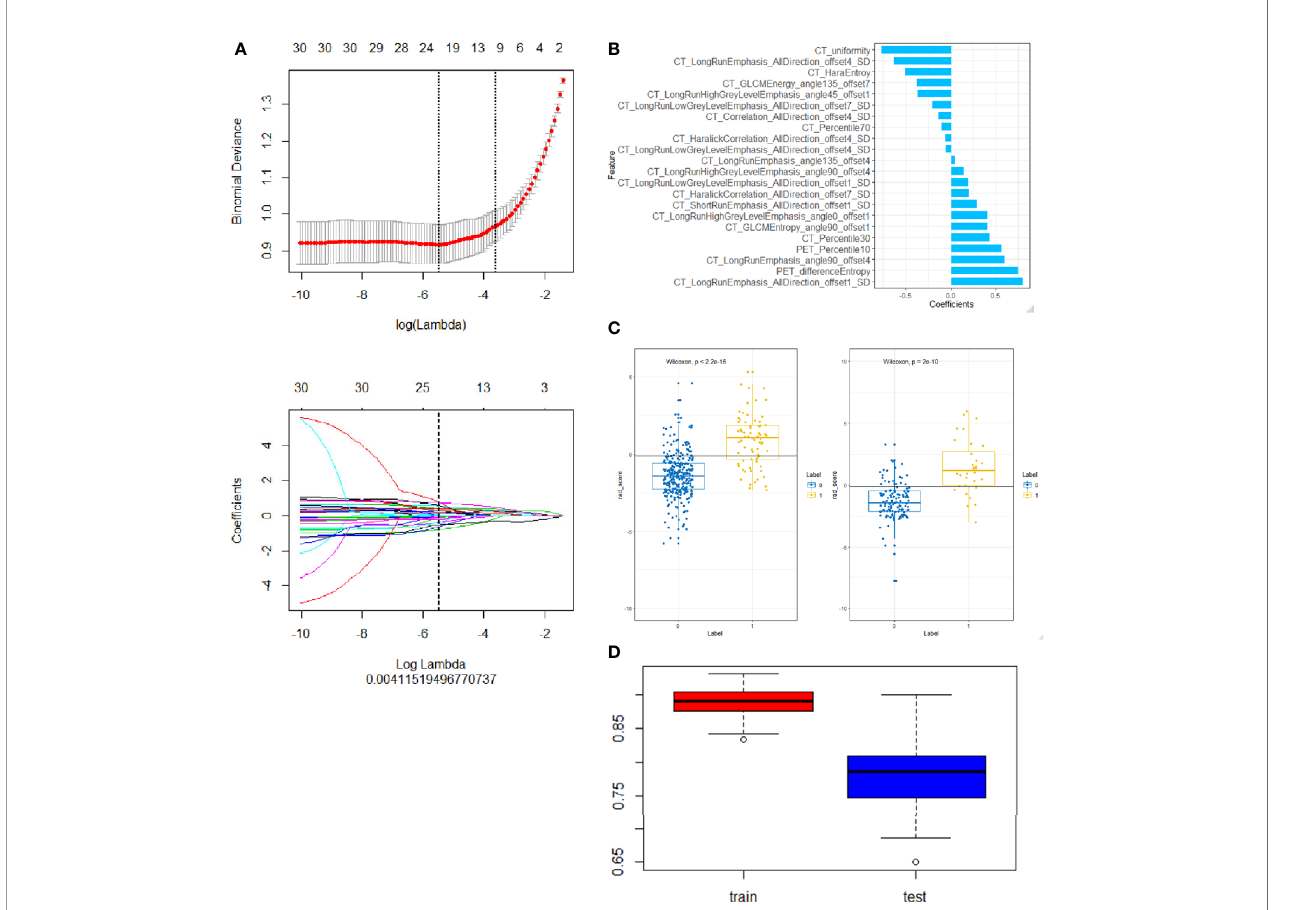
FIGURE 3 | Construction of a PET/CT radiomic model based on PET/CT images. (A) the Selection of the tuning parameter ( l ) in the LASSO model via 10-fold cross-validation based on minimum criteria. Binomial deviances of the LASSO regression cross-validation model are plotted as a function of ln ( l ). The y-axis shows binomial deviances and the lower x-axis the ln ( l ). Feature numbers along the upper x-axis indicate the number of features via the change of l . (B) The fi nal retained features selected by mRMR, y axis was the retained features and x axis shows the corresponding LASSO regression coef fi cients of them. The fi tted coef fi cients of the features plotted vs. ln ( l ). (C) Representative results of PET/CT radiomic model for predicting ALK rearrangement in training (left) and testing (right) group of lung adenocarcinoma patients. 0, negative ALK rearrangement; 1, positive ALK rearrangement. (D) Cross-validation analysis showed that PET/CT radiomic model has good reliability to predict ALK rearrangement in training (left) and testing (right) group of lung adenocarcinoma